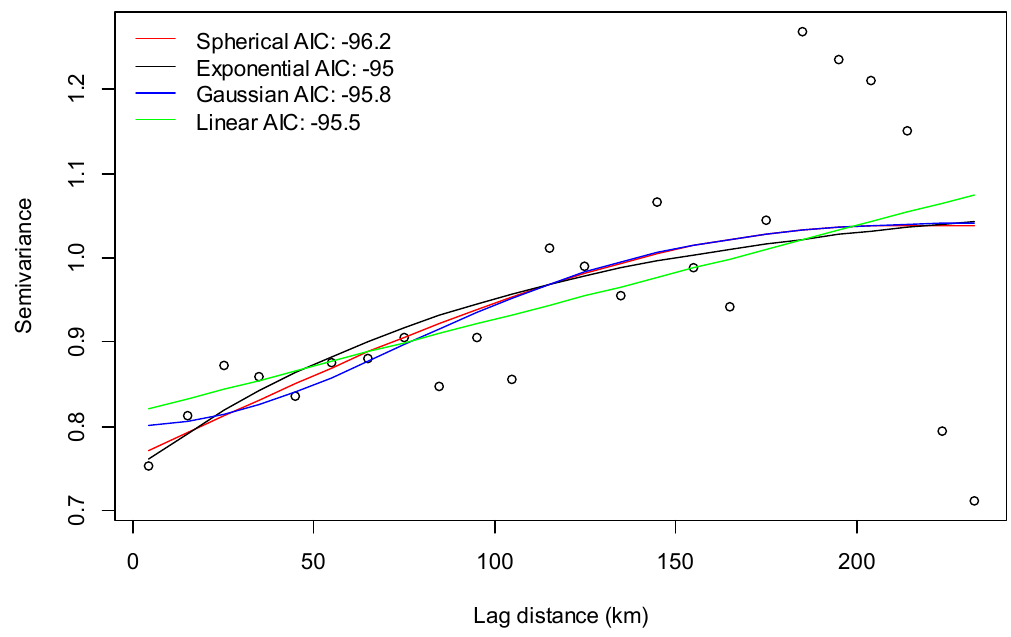
Figure 1. Empirical semivariogram plotted as points, with four fitted semivariance models shown as different colored lines. The best-fitting model (RMSE = 0.12) is represented by the exponential curve, with a range of 104.2 km, nugget = 0.74, and sill = 1.08.